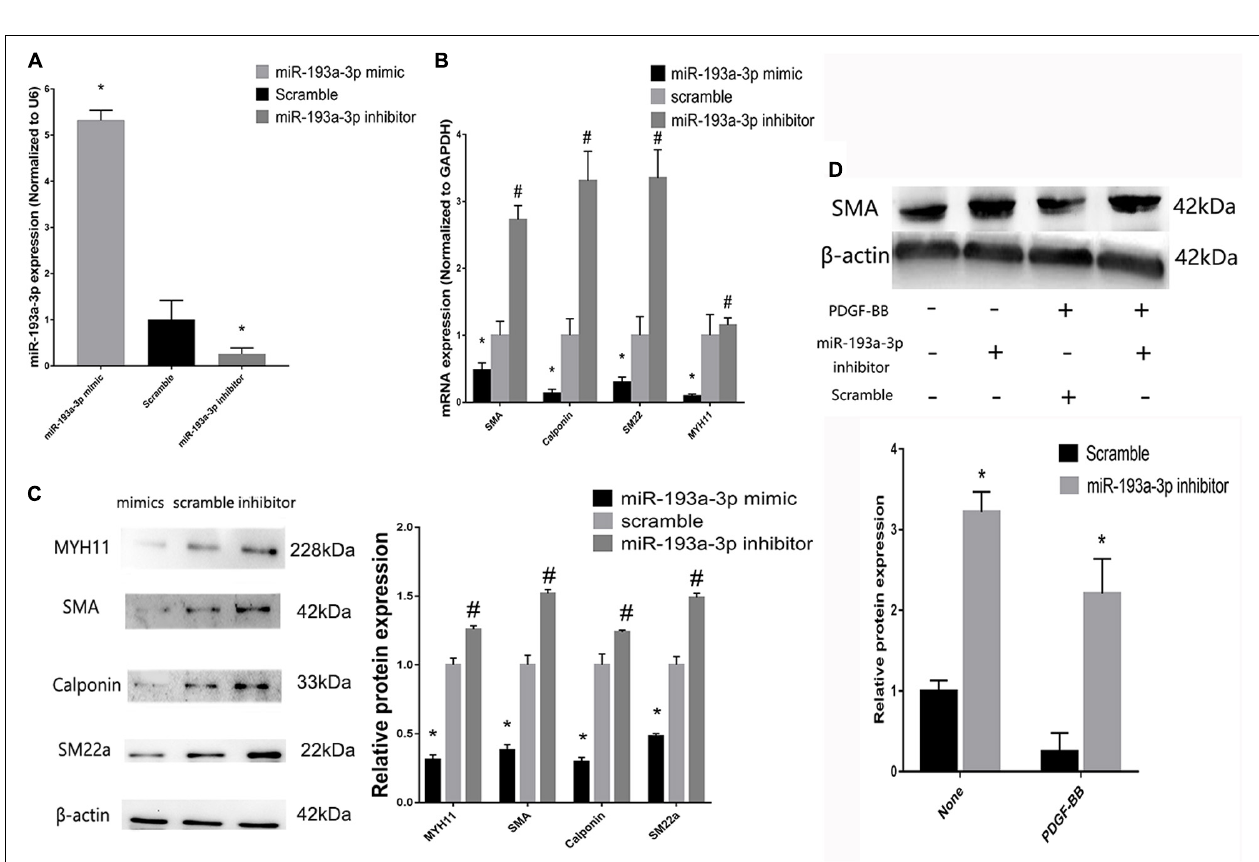
FIGURE 6 | miR-193a-3p regulates smooth muscle biomarkers in vitro . (A) qRT-PCR showing the overexpression and downregulation of miR-193a-3p after transfection with the miR-193a-3p mimic and inhibitor, respectively ( n = 10, * P ≤ 0.05 vs. Scramble). (B) miR-193a-3p inhibitor increased the expression of the differentiation biomarkers, whereas miR-193a-3p mimic downregulated the biomarkers ( n = 10, * P ≤ 0.05 vs. Scramble, # P < 0.05 vs. Scramble). (C) Western blots showing the decrease and increase in differentiation biomarker expression in miR-193a-3p inhibitor and mimic-transfected cells, respectively ( n = 3, * P < 0.05 vs. Scramble, # P ≤ 0.05 vs. Scramble). (D) Effect of miR-193a-3p on SMA expression in PDGF-BB stimulated VSMCs by densitometric analysis of SMA protein levels as measured by Western blot analysis ( n = 5). * P < 0.05 vs. scramble with or without PDGF-BB treatment (20